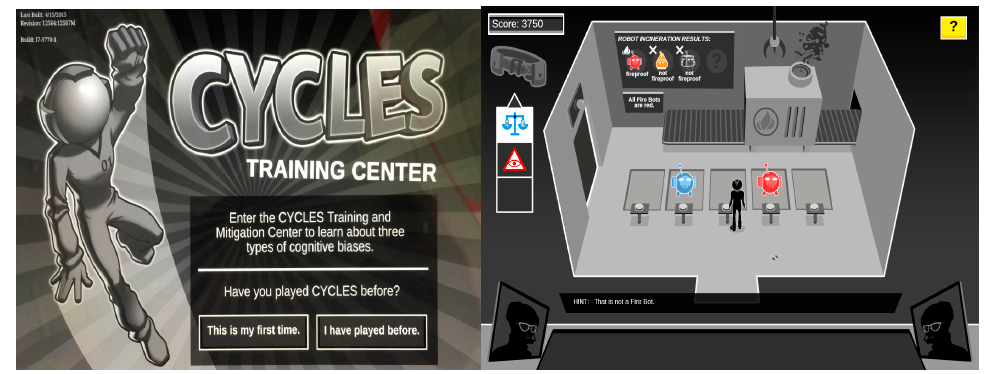
Figure 1. Screenshots from the final version of the CYCLES Training Center game illustrate the title screen and an example of one of the challenge rooms the player needed to navigate.